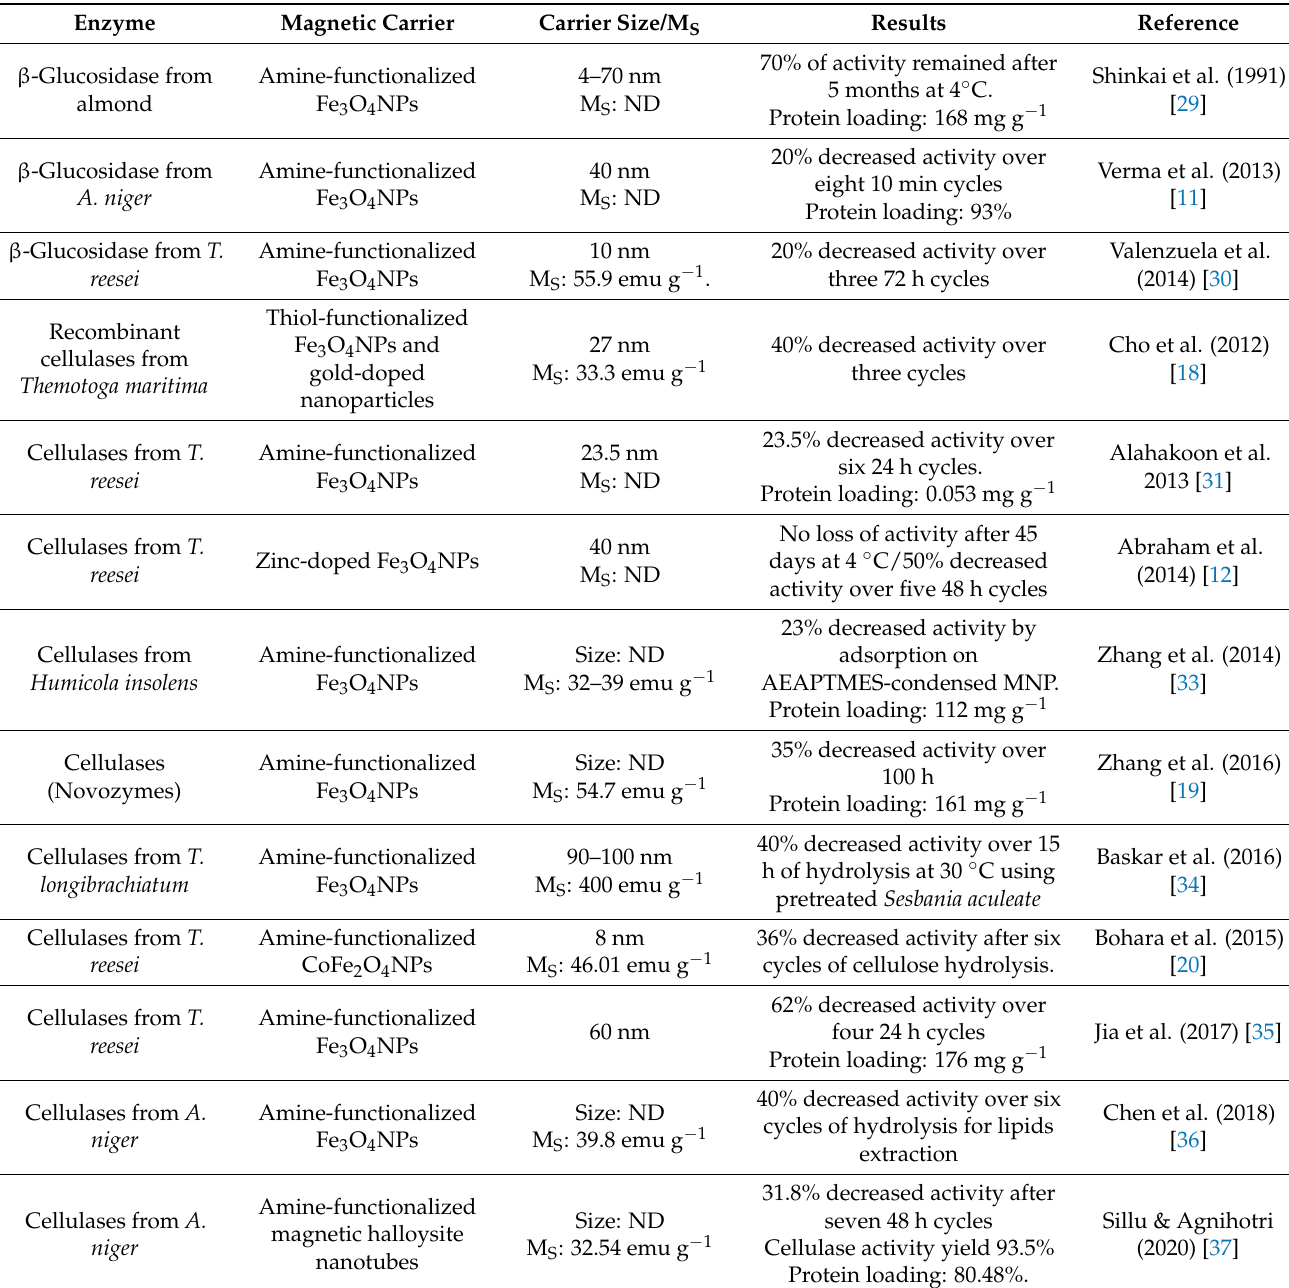
Table 1. Selected procedures of functionalized MNPs using cellulose-degrading enzymes and silica derivatives.